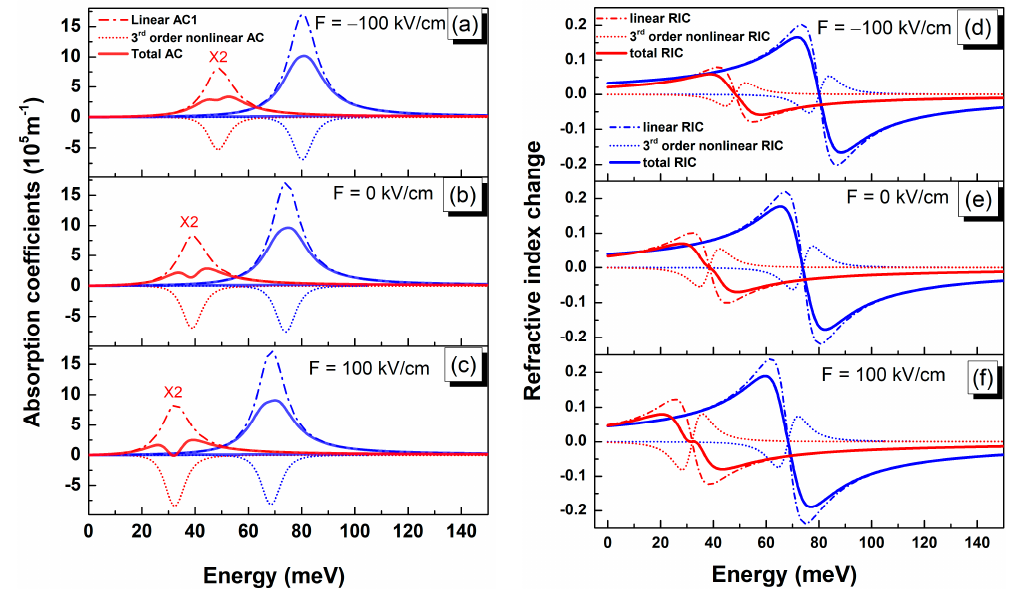
Figure 5. Absorption coe ffi cients ( a )–( c ) and Refractive index change ( d )–( f ) as a function of the photon energy evaluated for F = − 100 kV / cm ( a ) and ( d ), F = 0 kV / cm ( b ) and ( e ) and F = 100 kV / cm with an incident light intensity of 1 MW · cm − 2 . Linear contribution (dash-dot lines), 3rd order nonlinear component (dotted lines) as well as total AC and RIC (solid lines) for QD base side length: L = 25 nm (blue), L = 40 nm (red). The AC curves for L = 40 nm are multiplied by factor 2 for better